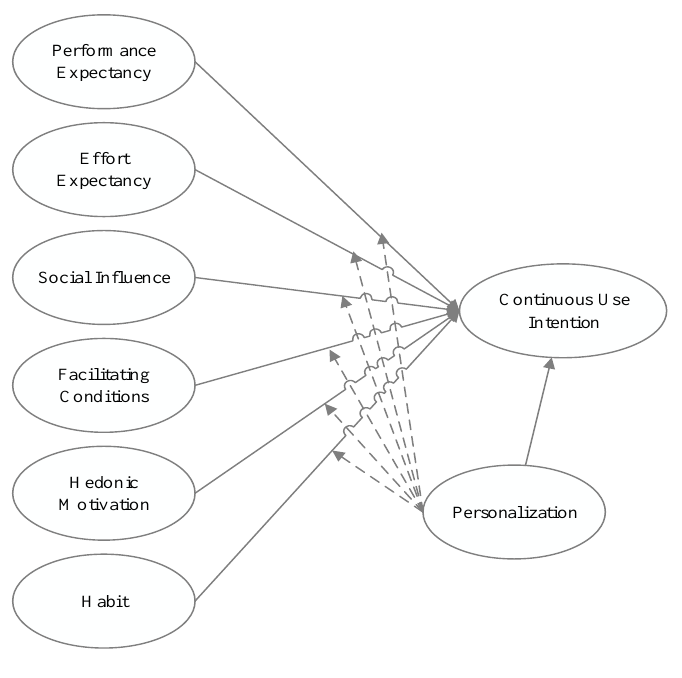
Figure 1. Research model.